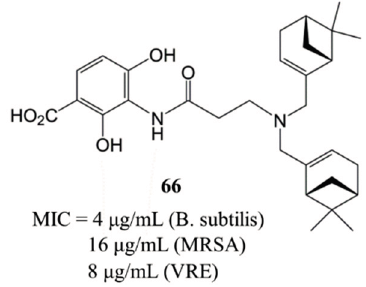
Figure 3. Structure and antibacterial activity (MIC, μ g/mL) of compound 66